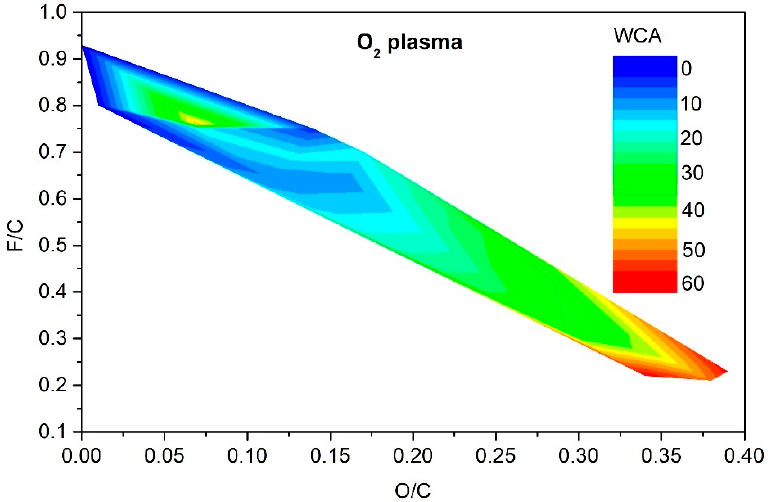
Figure 10. The change of the static water contact angle for various combinations of oxygen and fluorine surface concentrations obtained by oxygen plasma treatments.